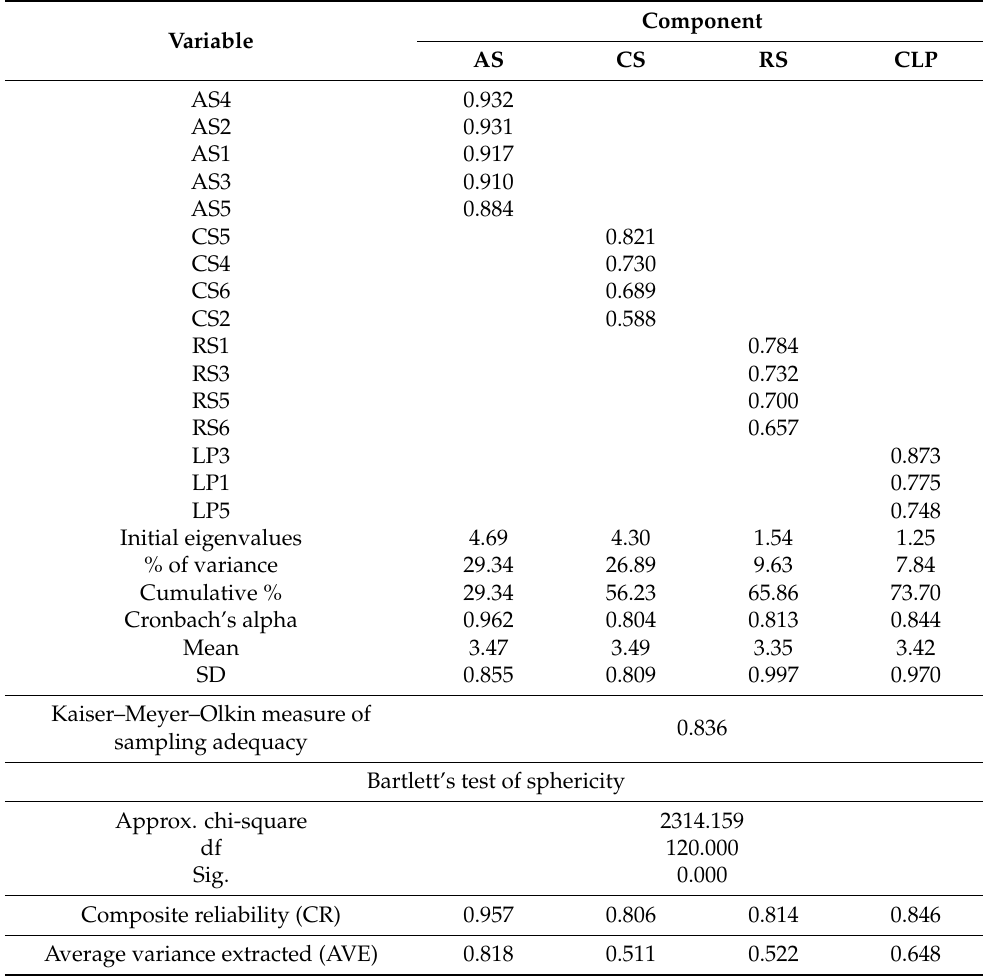
Table 5. Exploratory factor analysis and